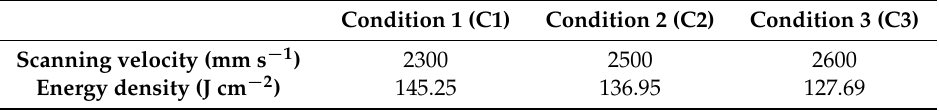
Table 1. Scanning velocities and energy densities applied for each